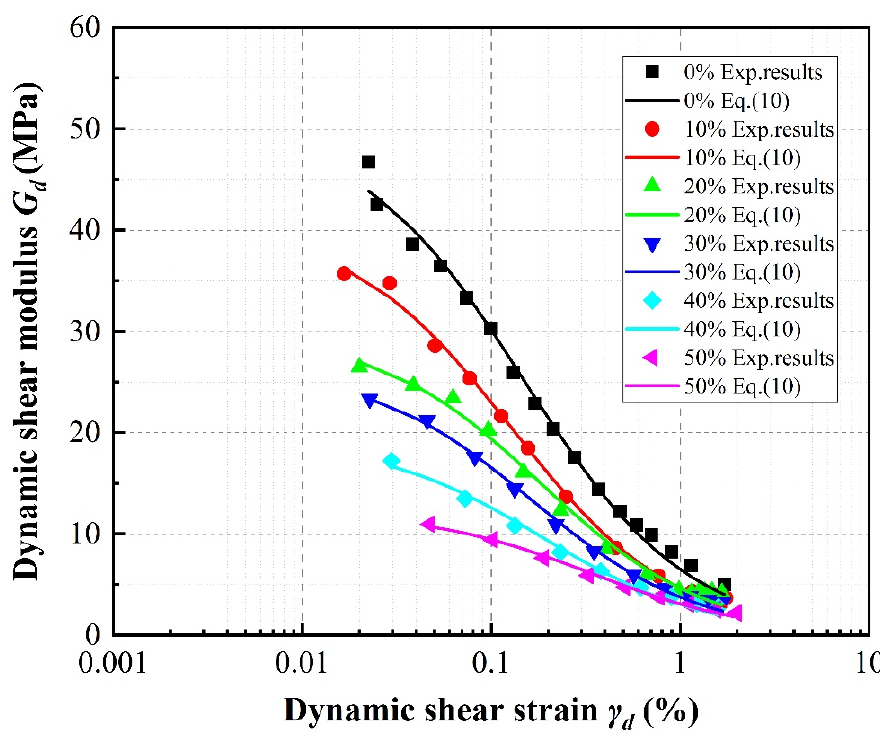
Figure 9. Effect of rubber content on dynamic shear moduli of SRP2 sand–rubber mixtures under 100 kPa confining pressure.